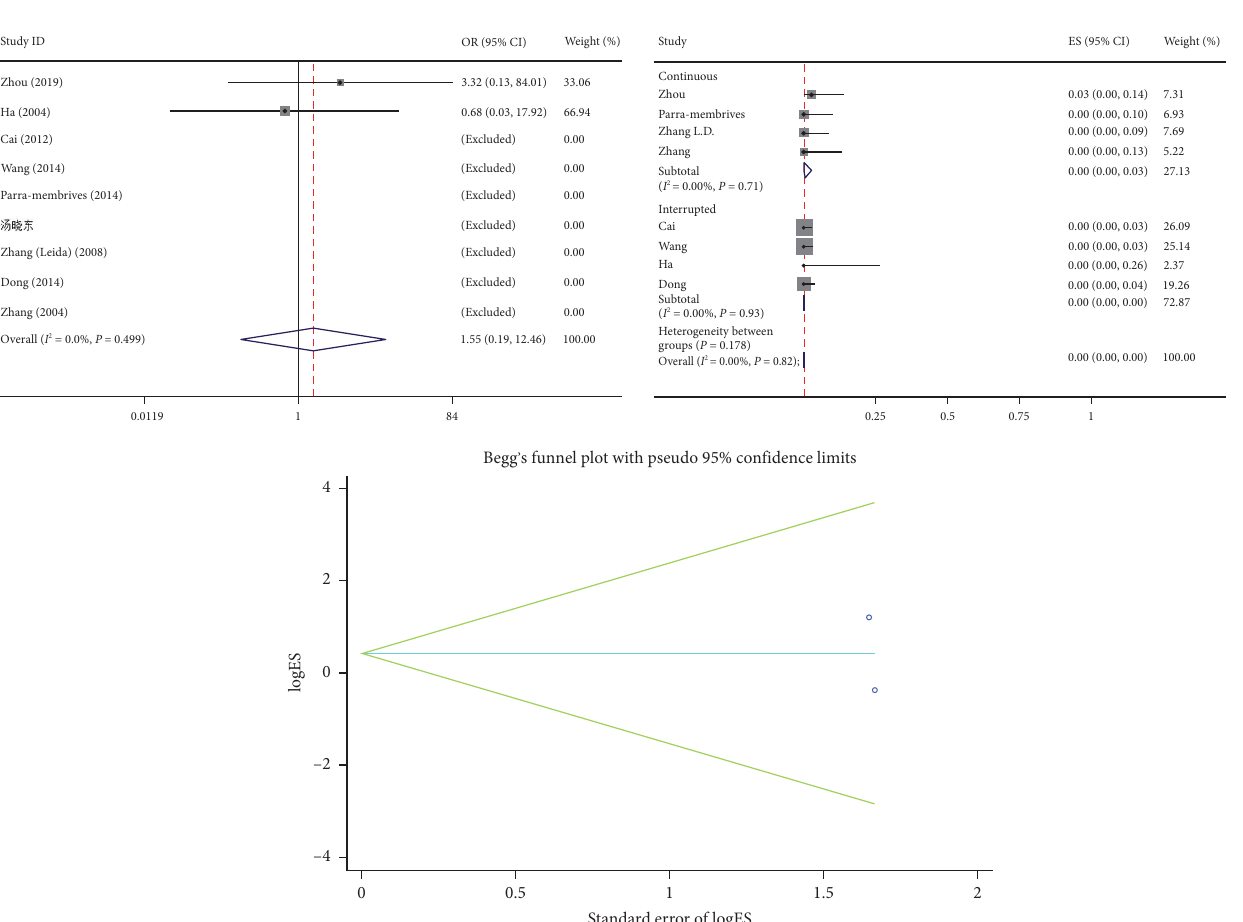
F IGURE 9: Forest plot of meta-analysis and single-arm meta-analysis and funnel plot of the bile duct stricture between the primary suture group and the T-tube drainage